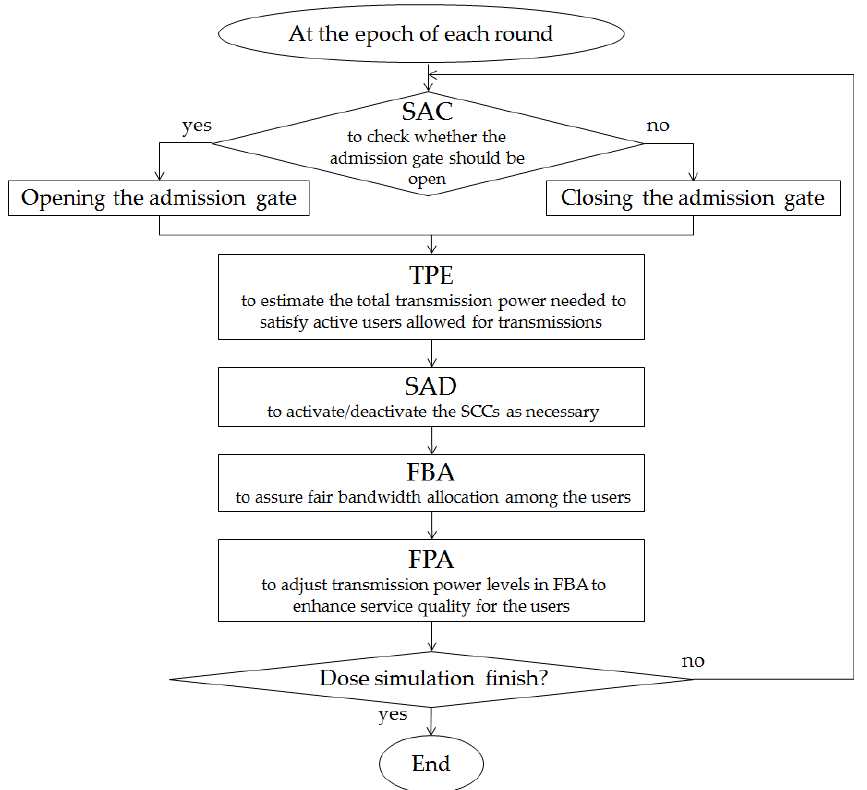
Figure 2. A conceptual flow chart of the proposed scheme.